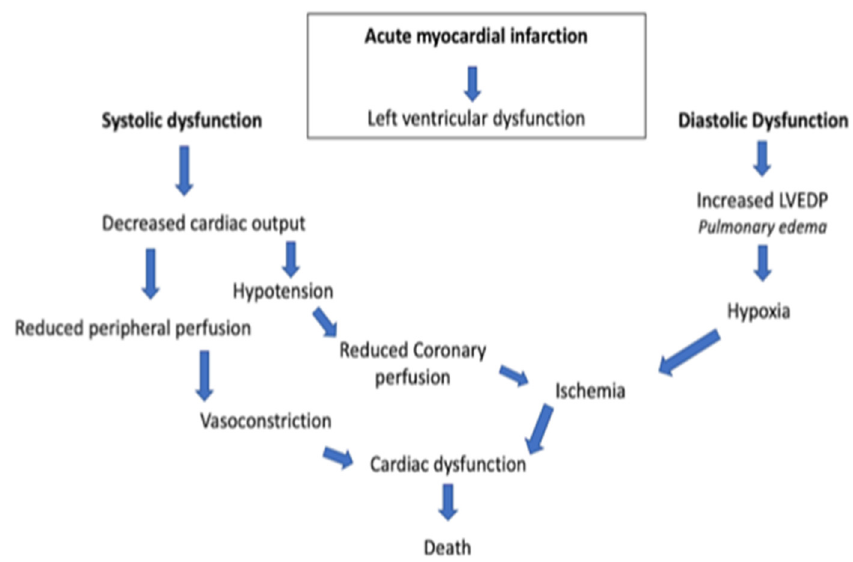
Figure 1. Acute myocardial infarction spiral. LVEDP, left ventricular end-diastolic pressure.